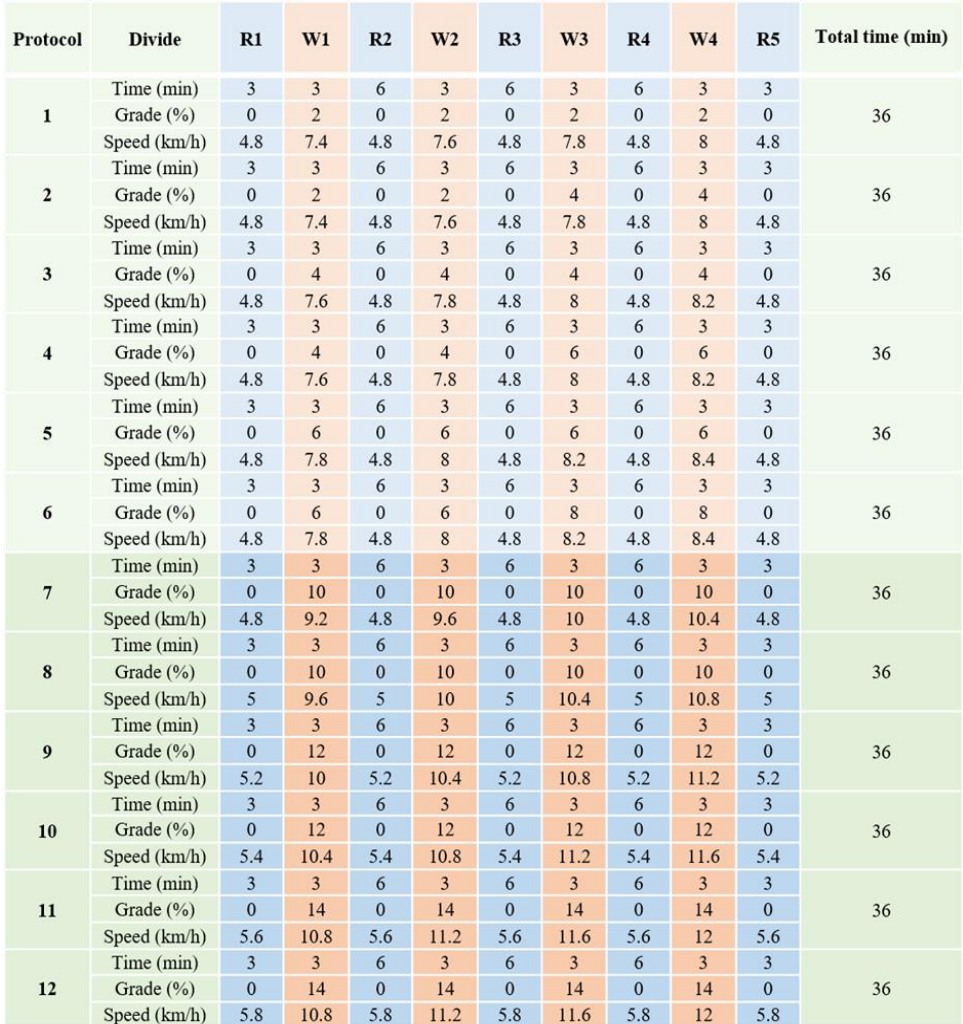
Figure 1. A 12-week interval exercise program consisting of 12 protocols. The 12 protocols include a gradual increase in grade (%) and speed (km/h) as the sessions